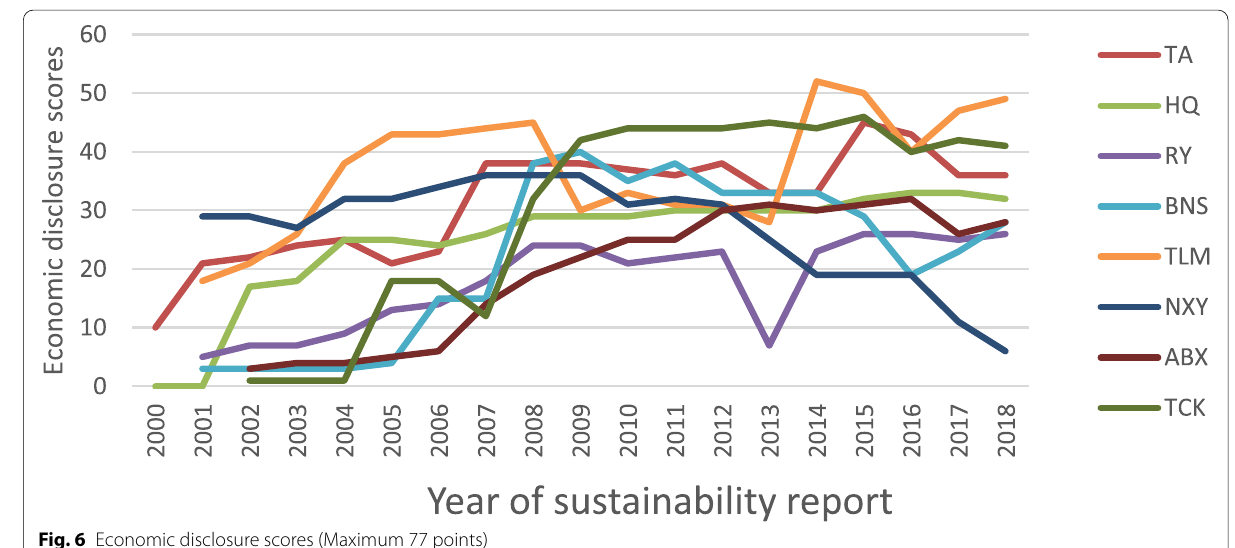
Fig. 6 Economic disclosure scores (Maximum 77